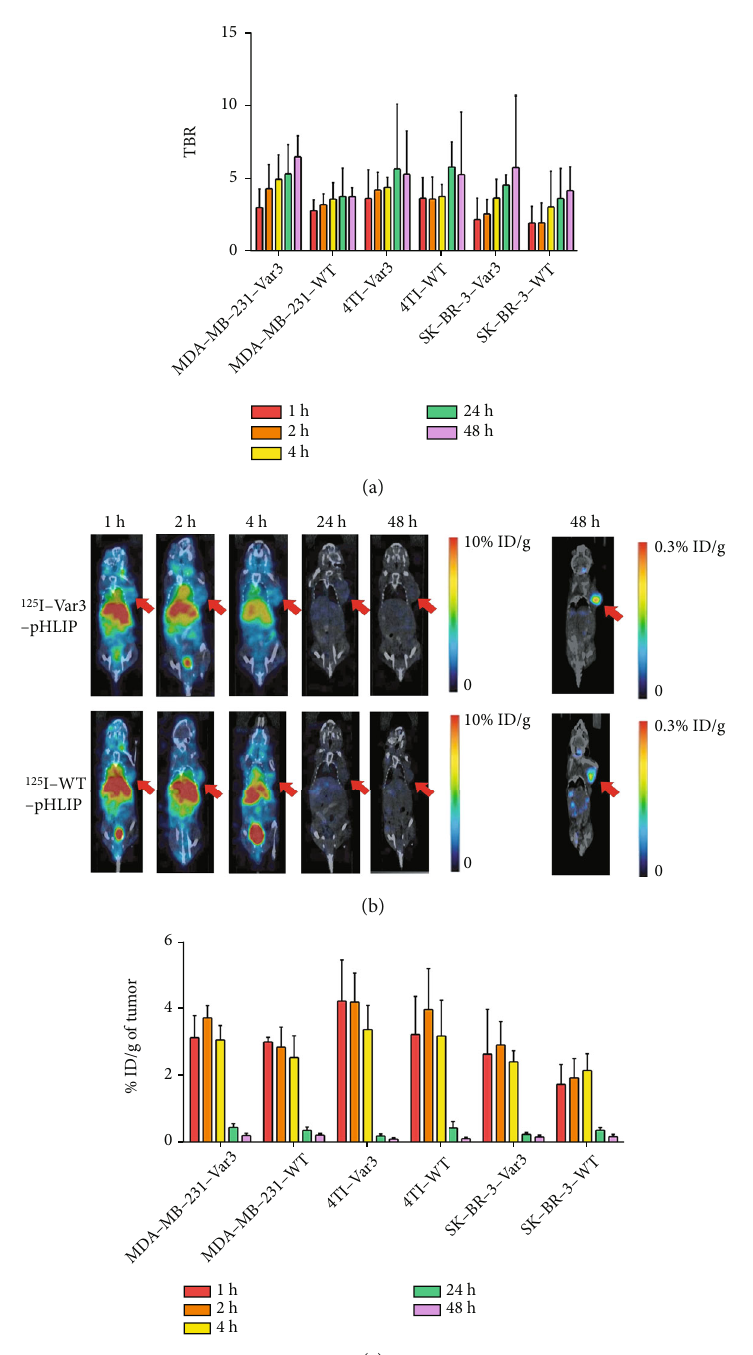
Figure 4: In vivo micro-SPECT/CT imaging and distribution of 125 I-labeled pHLIPs in MDA-MB-231, SK-BR-3, and 4T1 breast cancer xenografts. (a) Tumor-to-background ratio (TBR) of 125 I-labeled variant 3 (Var3)-pHLIP and 125 I-labeled wild-type (WT)-pHLIP in xenografts peaked at 24-48 h after injection. The TBR of 125 I-Var3-pHLIP was signi fi cantly higher than that of 125 I-WT-pHLIP at 48 h in MDA-MB-231 xenografts ( 6 : 51 ± 1 : 45 vs. 3 : 76 ± 0 : 61 , p = 0 : 013 ) but was not signi fi cantly di ff erent in 4T1 ( 5 : 32 ± 2 : 96 vs. 5 : 29 ± 4 : 29 , p = 0 : 992 ) and SK-BR-3 ( 5 : 77 ± 4 : 92 vs. 4 : 18 ± 1 : 64 , p = 0 : 562 ) xenografts. (b) In vivo micro-SPECT/CT imaging of 125 I-Var3-pHLIP (upper) and 125 I-WT-pHLIP (lower) in mice-bearing MDA-MB-231 tumors (red arrow). (c) The radioactive count of 125 I-Var3-pHLIP and 125 I-WT-pHLIP in xenografts peaked at 2 h after injection. Compared with 125 I-WT-pHLIP, the uptake of 125 I-Var3-pHLIP was signi fi cantly higher in MDA-MB-231 xenografts at 2h pi ( p = 0 : 046 ) but not in 4 T1 ( p = 0 : 781 ) or SK-BR-3 xenografts ( p = 0 : 077